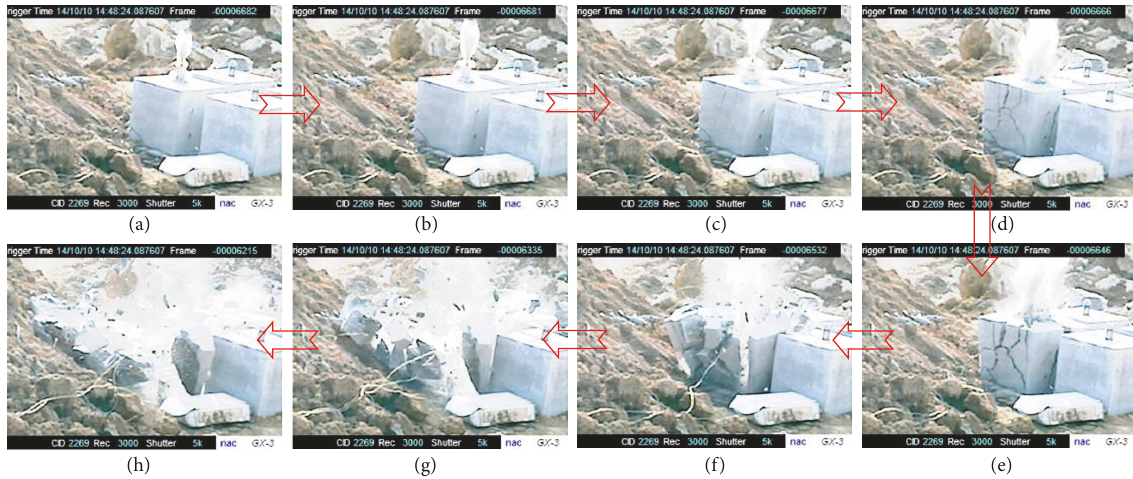
Figure 8: The process of pressured water coupling blasting in the A1B1C1 case: (a) No. 6682; (b) No. 6681; (c) No. 6677; (d) No. 6666; (e) No. 6646; (f) No. 6532; (g) No. 6335; and (h) No. 6215